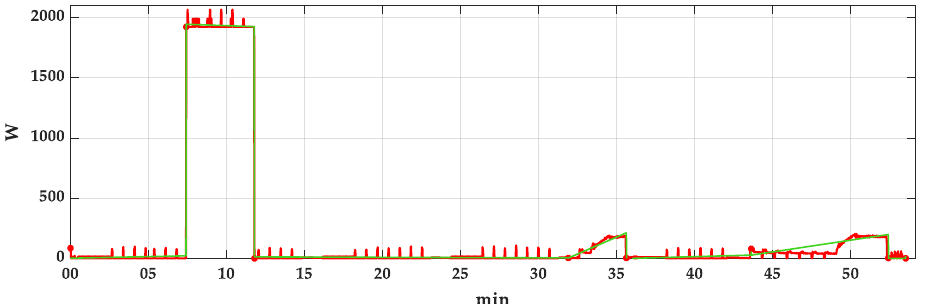
Figure 21. PWL approximation of the washing machine ’s load profile — RMS value 27.04 (measured data — red vs. approximated profile — green).